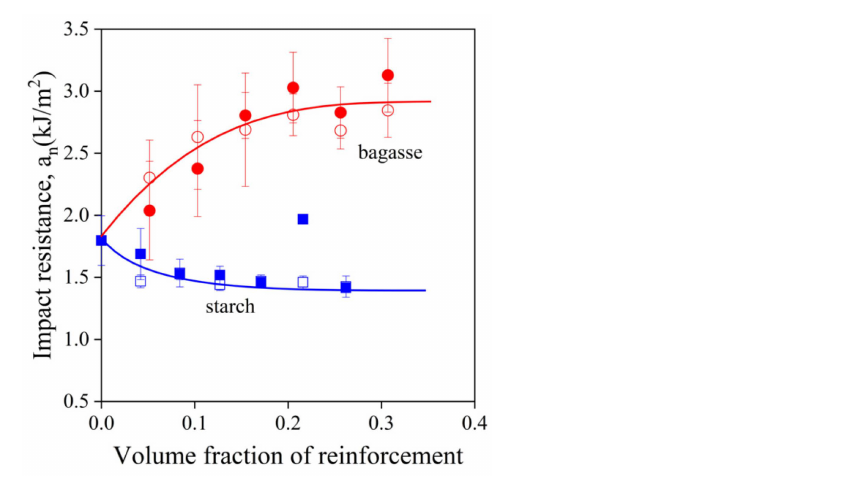
Figure 4. Dependence of the notched Charpy impact resistance of PLA composites containing natural Figure 2. Composition dependence of the stiffness of PLA composites reinforced with starch or ba- Figure 2. Composition dependence of the stiffness of PLA composites reinforced with starch or ba- Figure 2. Composition dependence of the stiffness of PLA composites reinforced with starch or ba- Figure 2. Composition dependence of the stiffness of PLA composites reinforced with starch or ba- reinforcements. Symbols: ( , ) sugarcane bagasse fibers, ( , ) starch; empty symbols without gasse fibers. Effect of coupling. Symbols: (  ,  ) sugarcane bagasse fibers, (  ,  ) starch; empty gasse fibers. Effect of coupling. Symbols: (  ,  ) sugarcane bagasse fibers, (  ,  ) starch; empty gasse fibers. Effect of coupling. Symbols: (  ,  ) sugarcane bagasse fibers, (  ,  ) starch; empty gasse fibers. Effect of coupling. Symbols: (  ,  ) sugarcane bagasse fibers, (  ,  ) starch; empty symbols without MAPLA, full symbols with MAPLA. symbols without MAPLA, full symbols with MAPLA. symbols without MAPLA, full symbols with MAPLA. MAPLA, full symbols with symbols without MAPLA, full symbols with MAPLA.